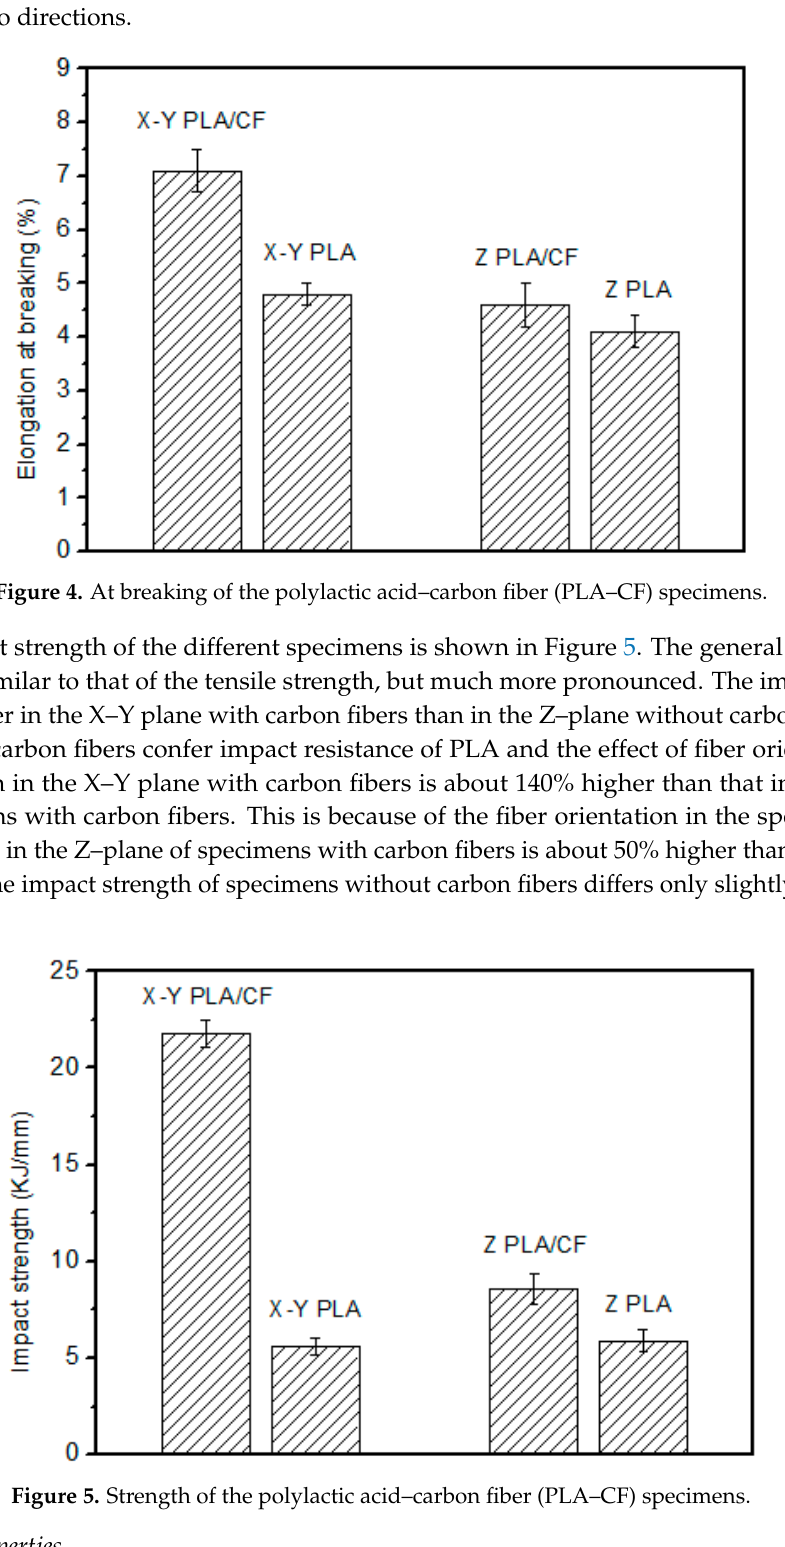
Figure 3. Tensile strength of the polylactic acid–carbon fiber (PLA–CF) specimens. 137